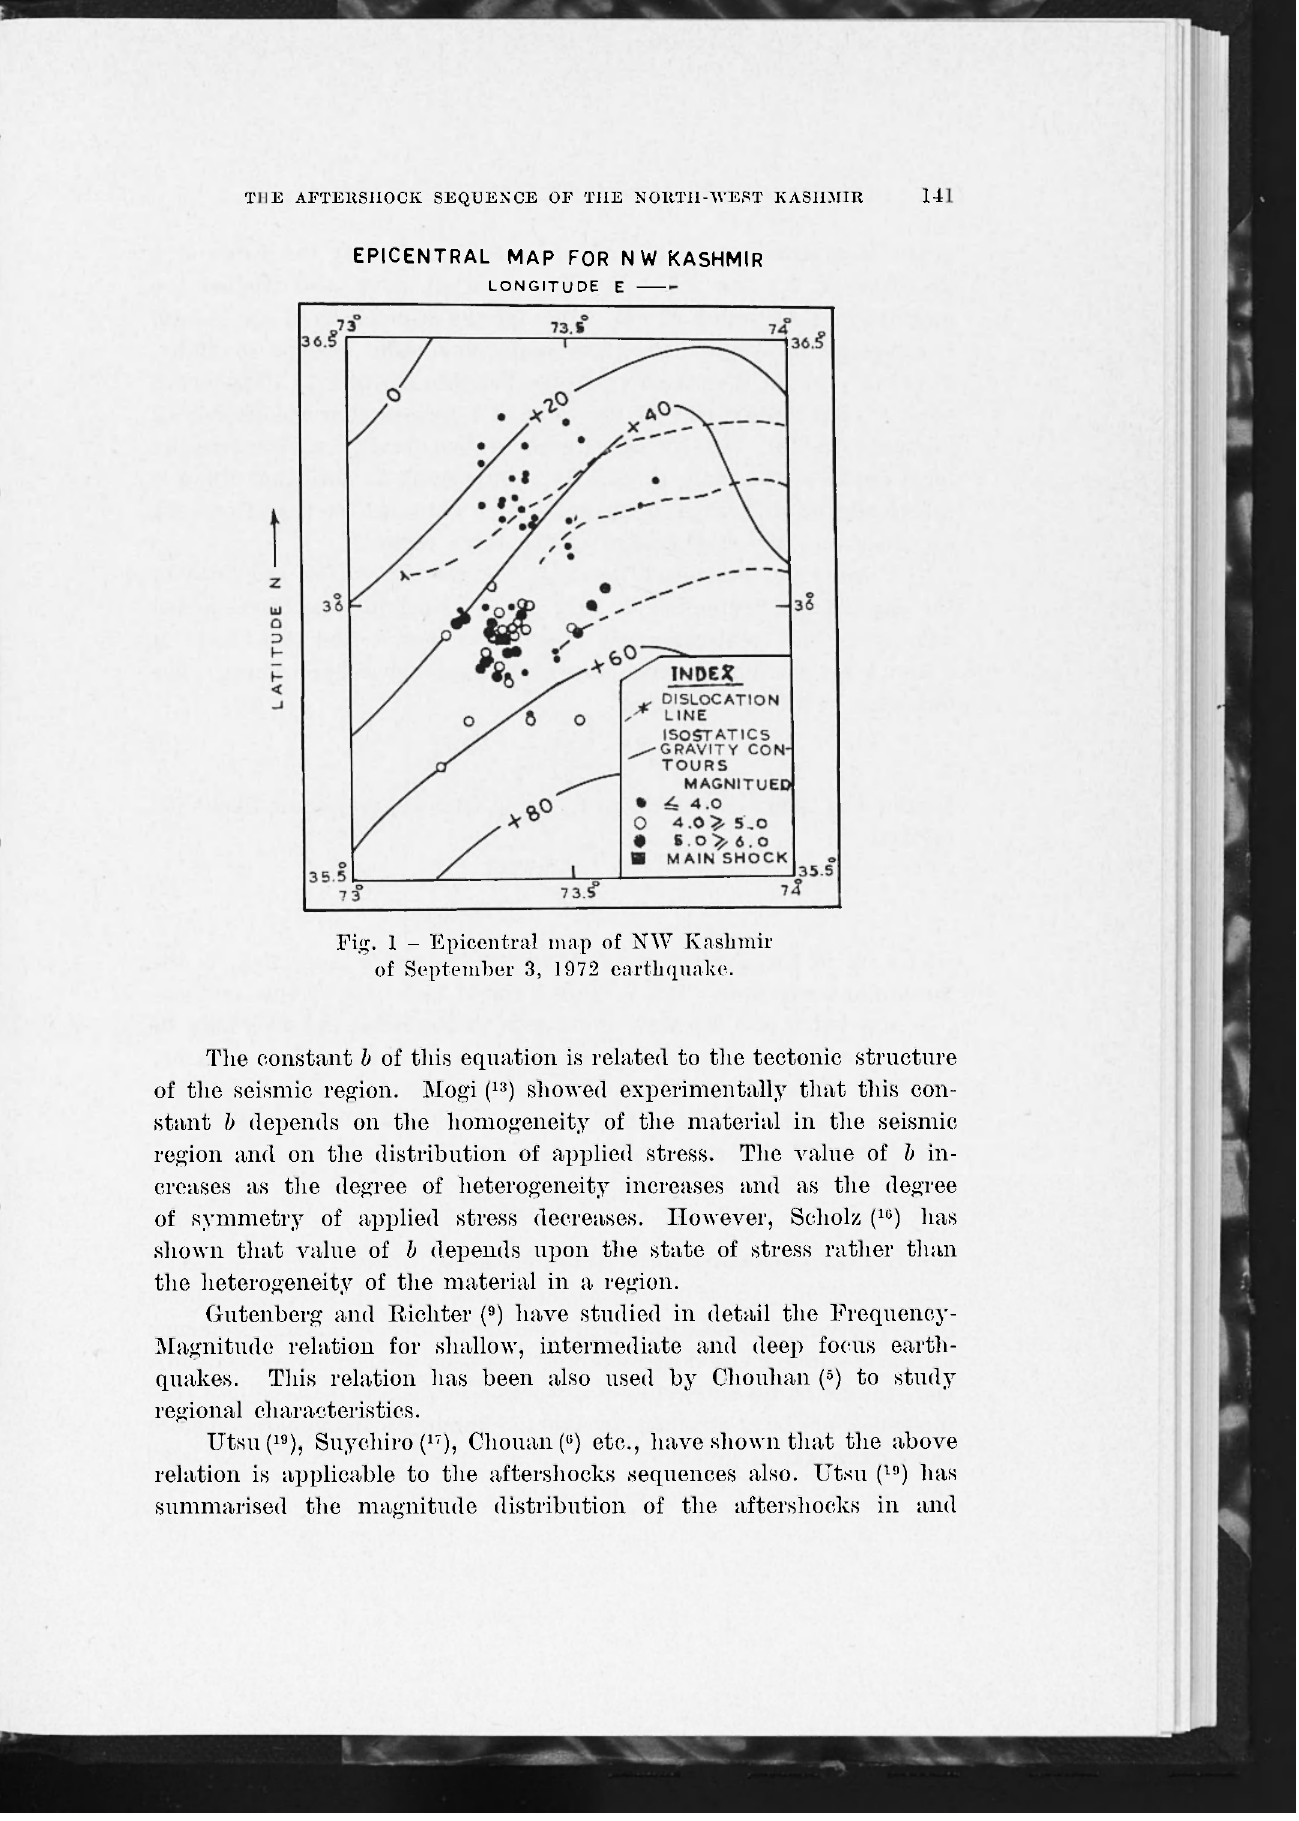
Fig. 1 - Epicentral map of NW Kashmir of September 3, 1972